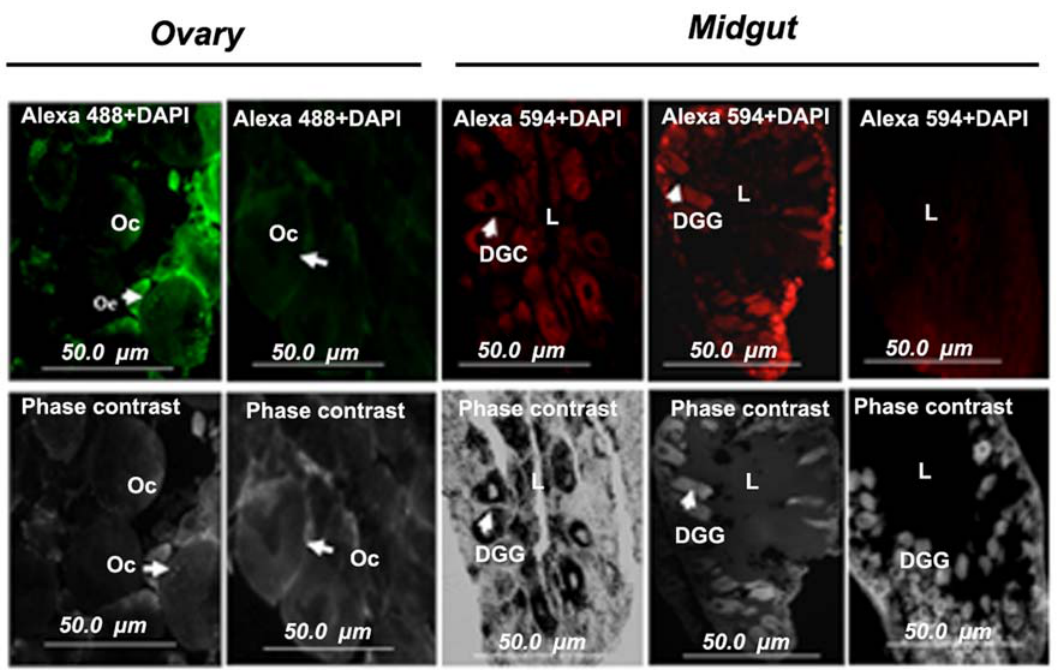
Figure 6. Localization of LKR/SDH in ovary and midgut cells by IFAT. Slides of ovary or midgut tissue from adults 4 days post-engorgement were used with mouse anti-SDH serum as primary antibodies. The mouse anti-IgG conjugated with Alexa 488 was used as a secondary antibody for ovarian tissues and mouse anti-IgG conjugated with Alexa 594 for midgut tissues. DGC, digestive cell; Oc, oocyte; L, midgut lumen. Magnification, 6 20.